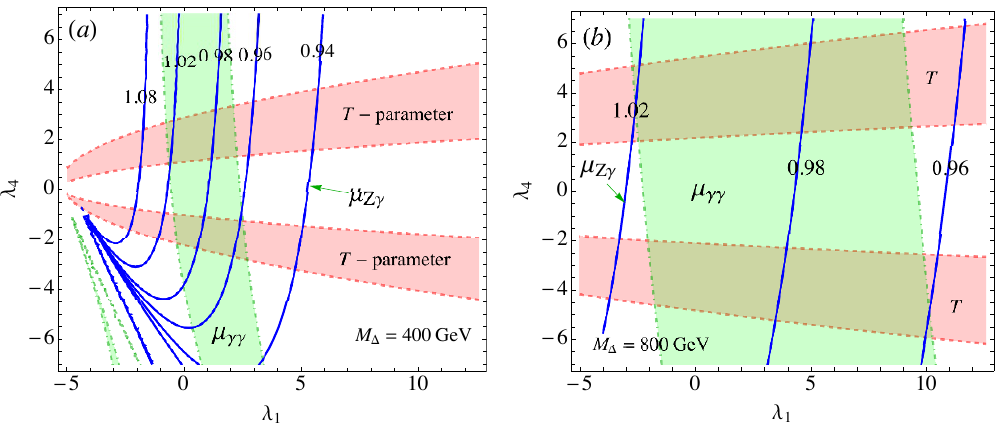
Figure 10 . Contours for signal strength of h ! Z(cid:13) as a function of (cid:21) 1 and (cid:21) 4 for (a) M (cid:1) = 400 GeV and (b) M (cid:1) = 800 GeV, where the T -parameter and (cid:22) (cid:13)(cid:13) constraints are also